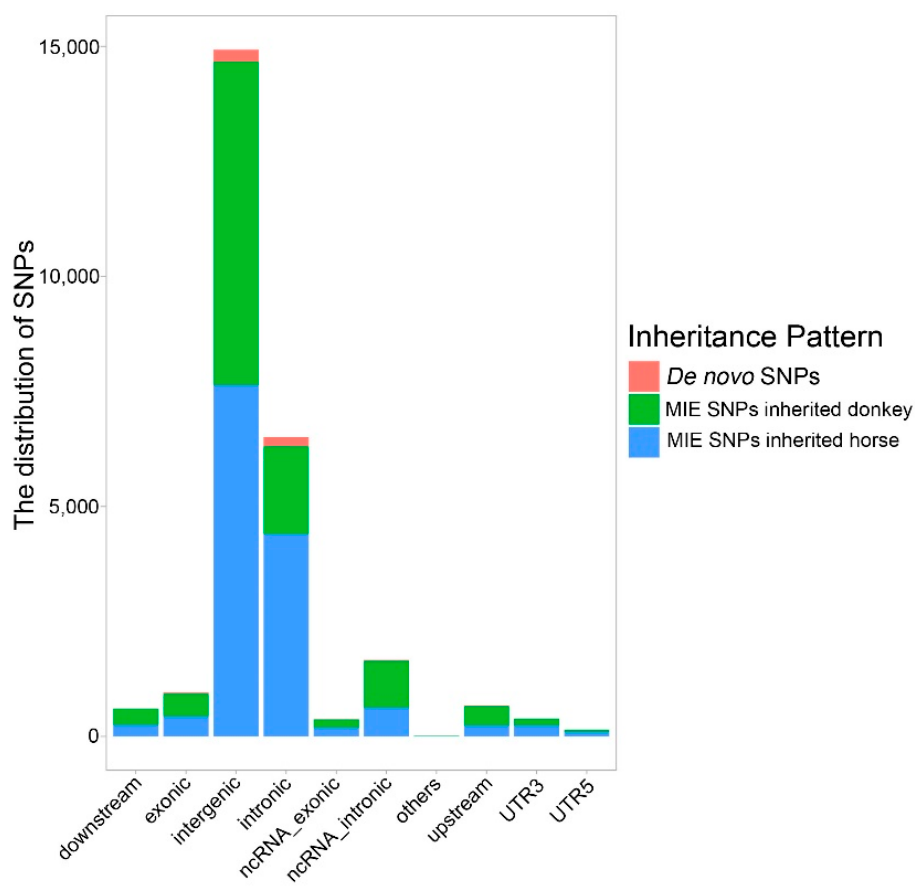
Figure 2. The statistics of SNP distribution.